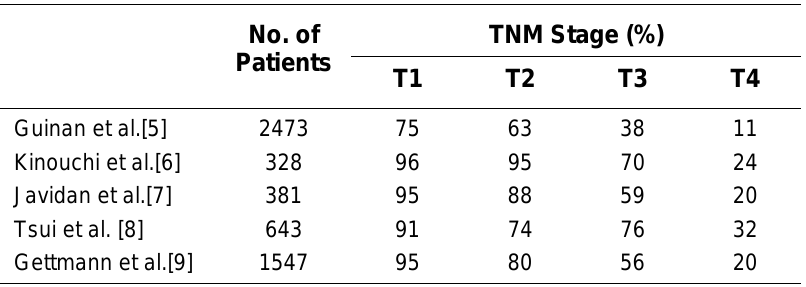
Five-Year Survival Rate of RN by TNM Stage TNM Stage (%) No. of Patients T1 T2 T3 T4 Guinan et al.[5] 2473